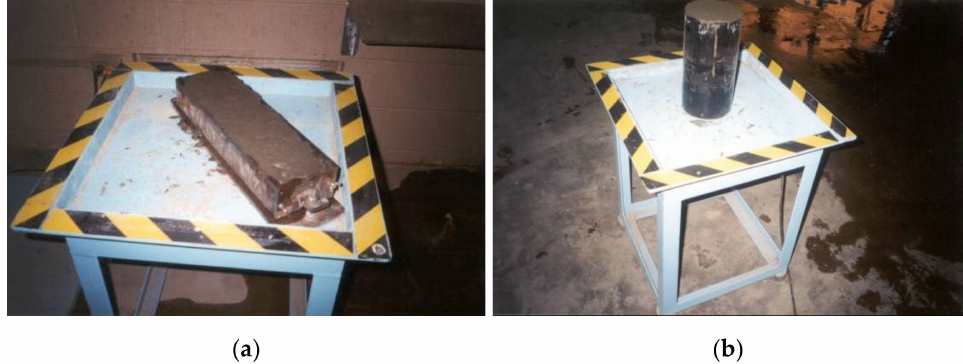
Figure 3. Beam ( a ) and cylinder ( b ) specimens cast for flexure and impact tests.